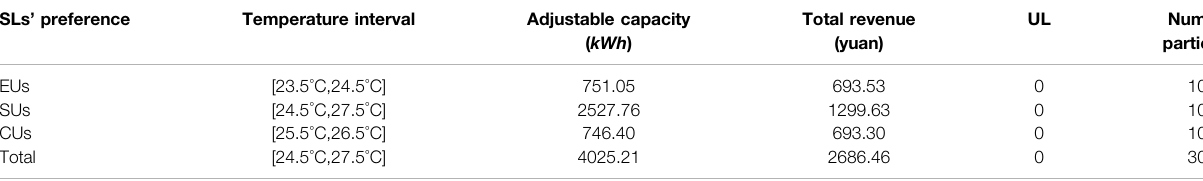
TABLE 2 | One-hour schedulable capacity in consideration of SLs ’ preferences.